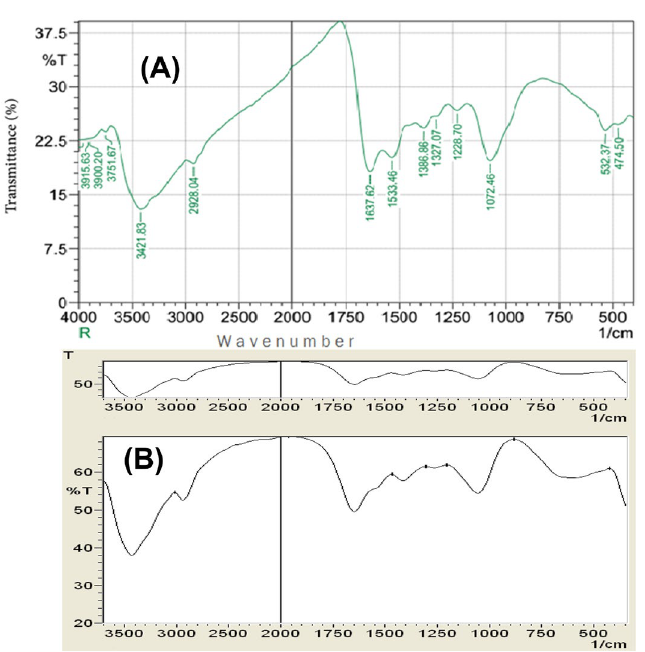
Figure 4. Fourier-Transform Infra-Red spectra (FT-IR) spectra shows ( A ) the functional groups associated with Ag NPs synthesized by using C. sinuosa extract and ( B ) C. sinuosa